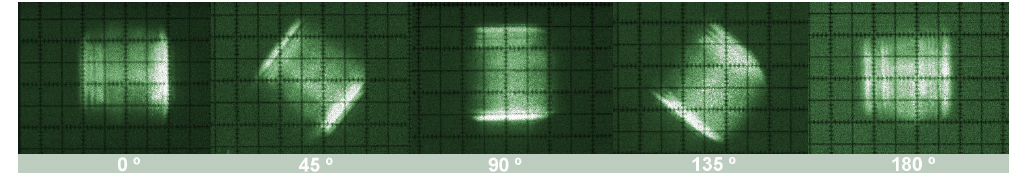
Figure 9. Photograph of the cross-sections of the beams emitted at 0°, 45°, 90°, 135° and 180°.